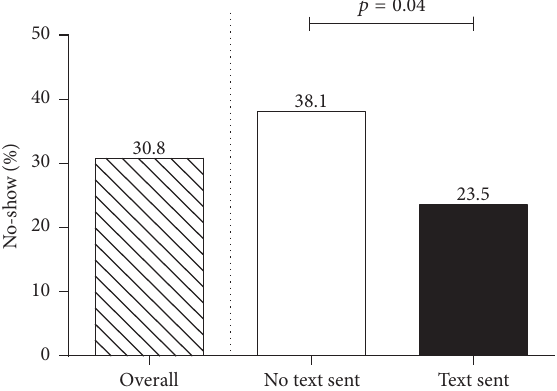
Figure 2: No-show rate for text sent and not sent.